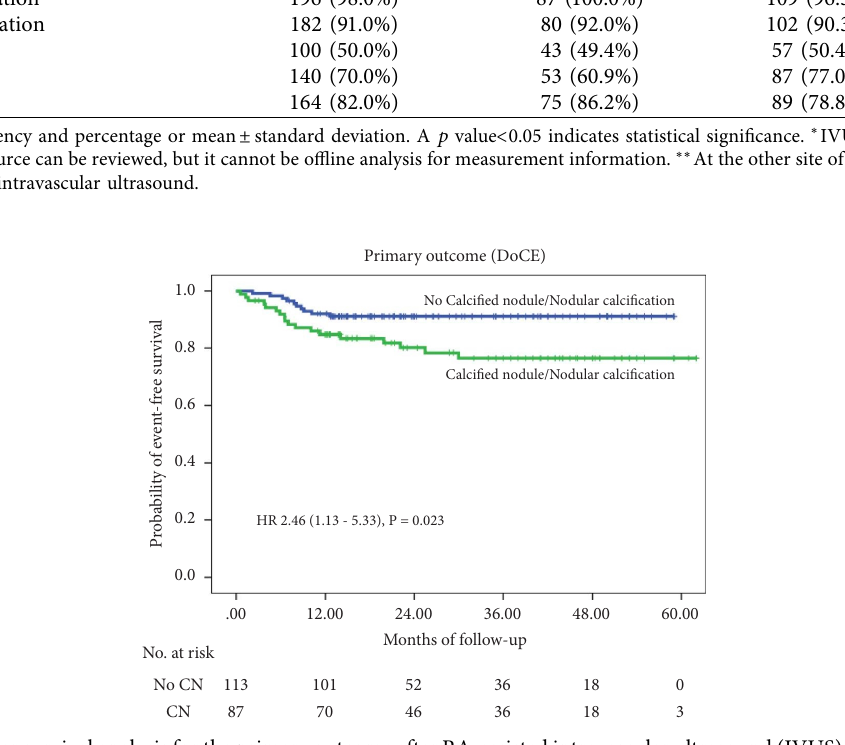
Figure 2: Kaplan-Meier survival analysis for the primary outcome after RA-assisted intravascular ultrasound (IVUS)-guided PCI compared between those with and without calcifed nodule/nodular calcifcation. DoCE: device-oriented composite endpoint; RA: rotational atherectomy; IVUS: intravascular ultrasound; and PCI: percutaneous coronary